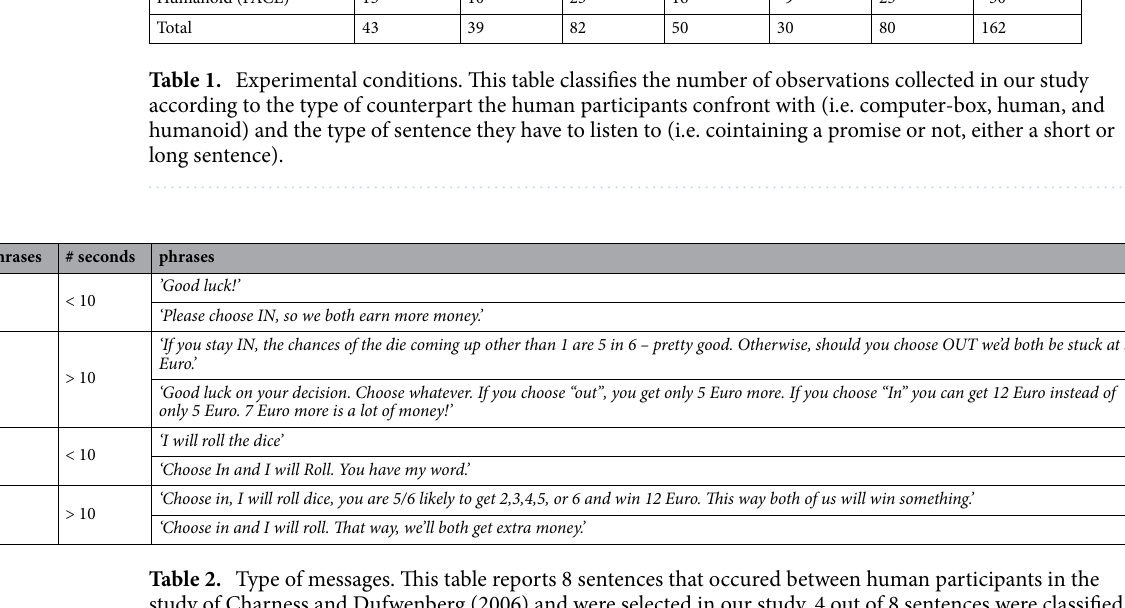
Grand totalShort Long Total